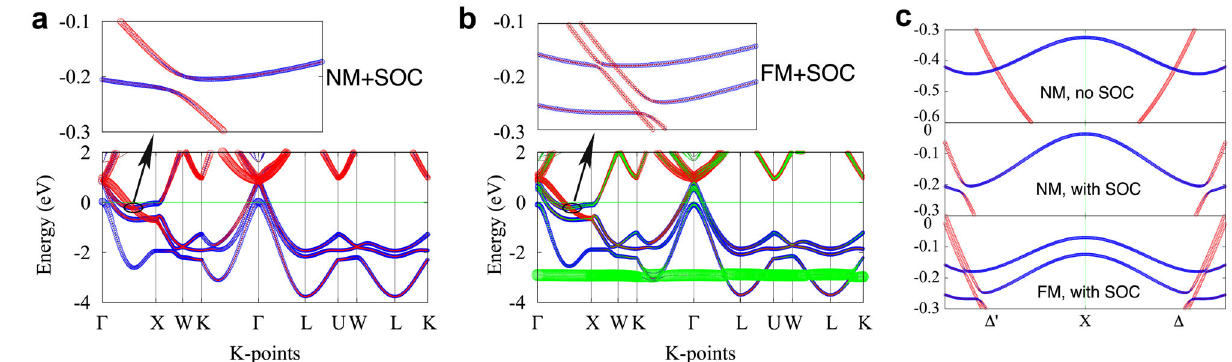
Fig. 4 Electronic structure calculations for CeSb. a The electronic structure of CeSb in the non-magnetic case but including spin-orbit coupling. The red and blue colours represent Ce-5 d and Sb-5 p orbitals, respectively. A magni fi cation of the region where the band inversion occurs between Γ and X is also displayed, which is fully gapped. b The electronic structure of CeSb in the ferromagnetic state. In addition to the Ce-5 d and Sb-5 p orbitals, the Ce-4 f orbitals are now explicitly included and are shown by green. The inset also shows an enlarged view of the band inversion, where two Weyl points between Γ and X can be seen. c Diagram displaying how the combination of spin-orbit coupling (SOC) and ferromagnetism (FM) can lead to the emergence of two pairs of Weyl points. On the top , the case is shown for the non-magnetic system without spin-orbit coupling where there are two band crossings with four-fold degeneracy at the crossing points. Turning on the spin- orbit coupling gaps out these points and generates band inversions. In the ferromagnetic state, the Zeeman splitting again leads to gapless regions but with half the degeneracy of the fi rst case, signifying the appearance of Weyl